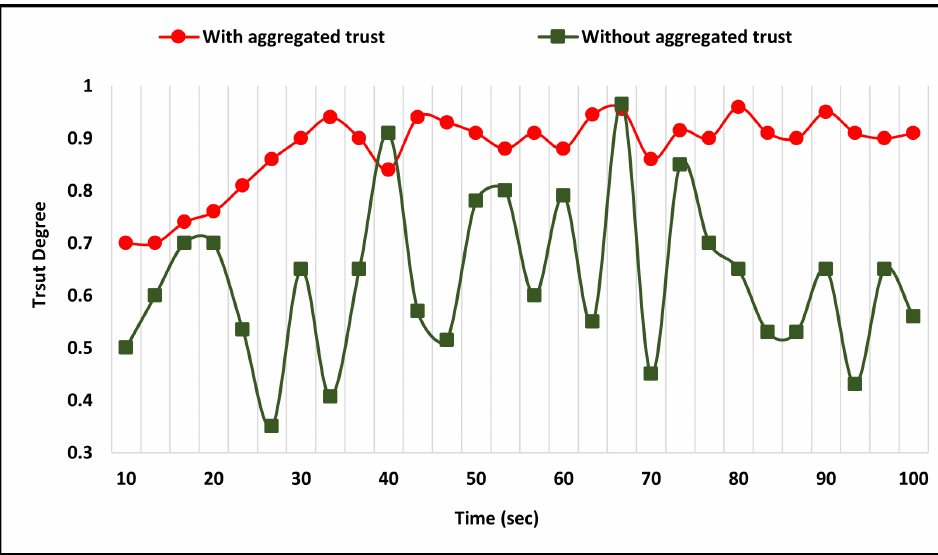
Figure 2. Previous Trust Aggregation Impact on Direct Trust